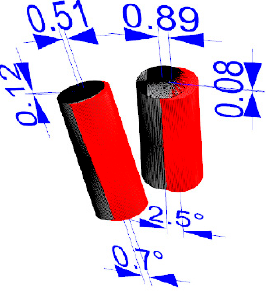
Figure 5. Measurement of the virtual planning accuracy by superimposition of the STL derived from the planning with the STL taken after implant placement.